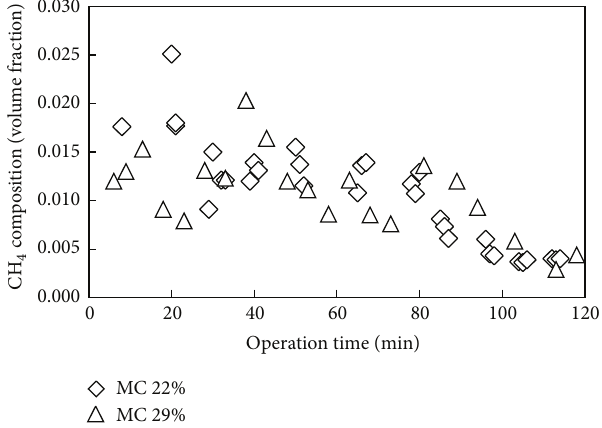
Figure 5: Methane content in syngas over operation time for fuel of different moisture content.